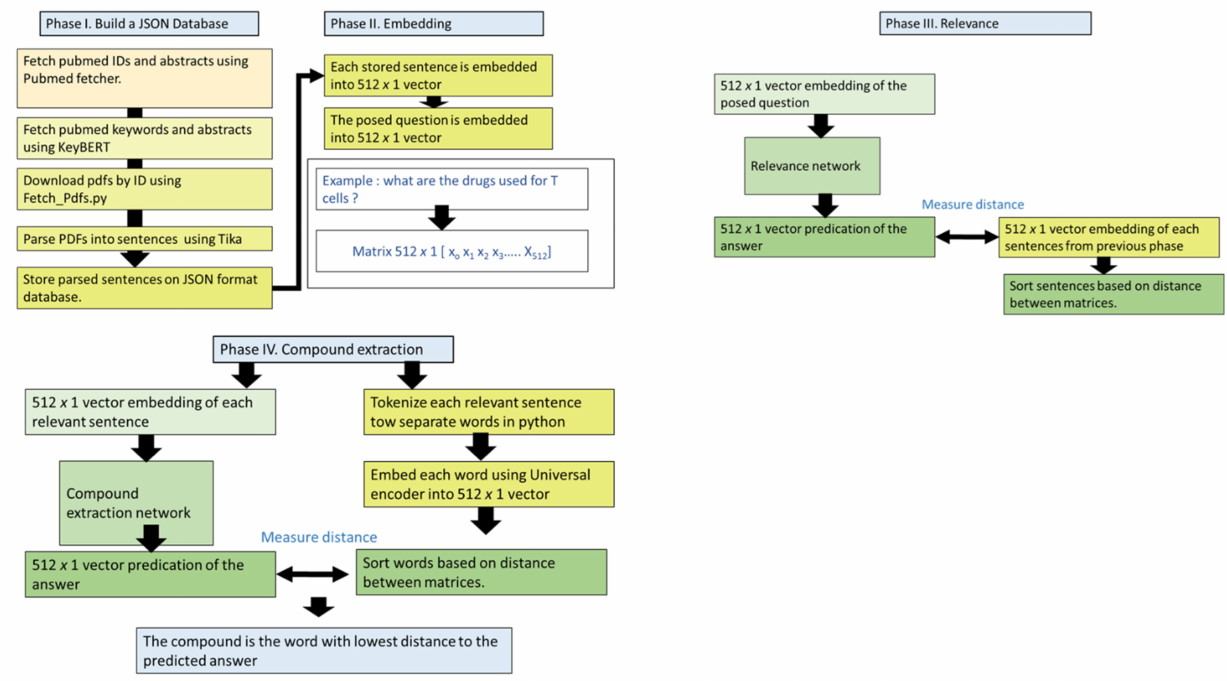
Figure 1. A detailed workflow of our proposal. There are four phases in the workflow. The user first enters a disease or a primary pathway to be investigated. The search step is done to select relevant PubMed articles. Then each accepted article is sorted and parsed. The first network converts each sentence in each PDF to a single embedding matrix. The second neural network sorts each sentence in each PDF based on its relevance to the query. The third neural network extracts drug names from each relevant